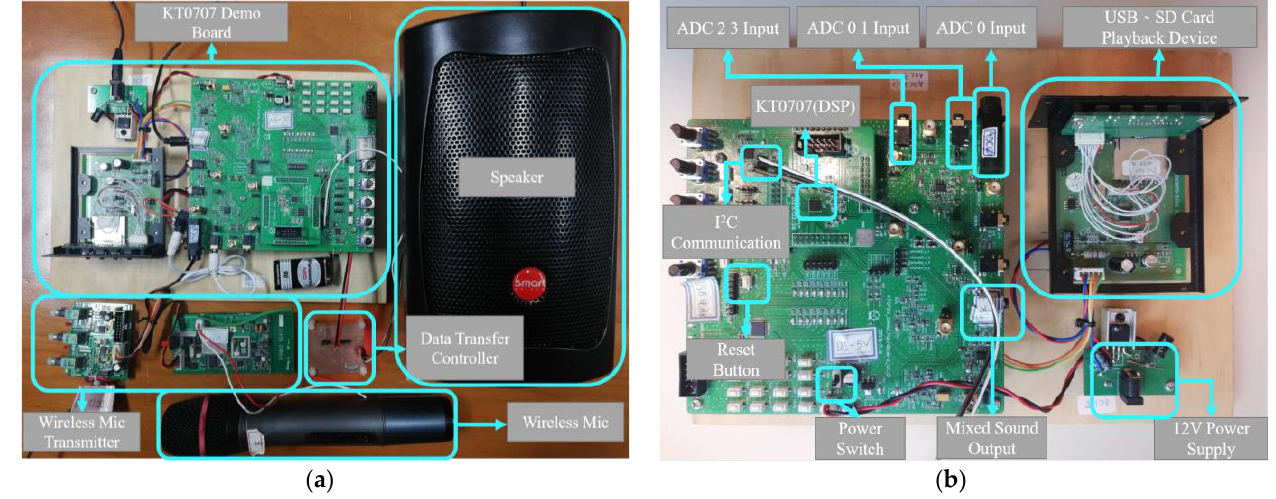
Figure 9. The actual prototype design of the proposed system: ( a ) complete hardware and ( b ) KT0707 demo board. Table 3. A comparison between commercial smart speakers, mixers, and the proposed